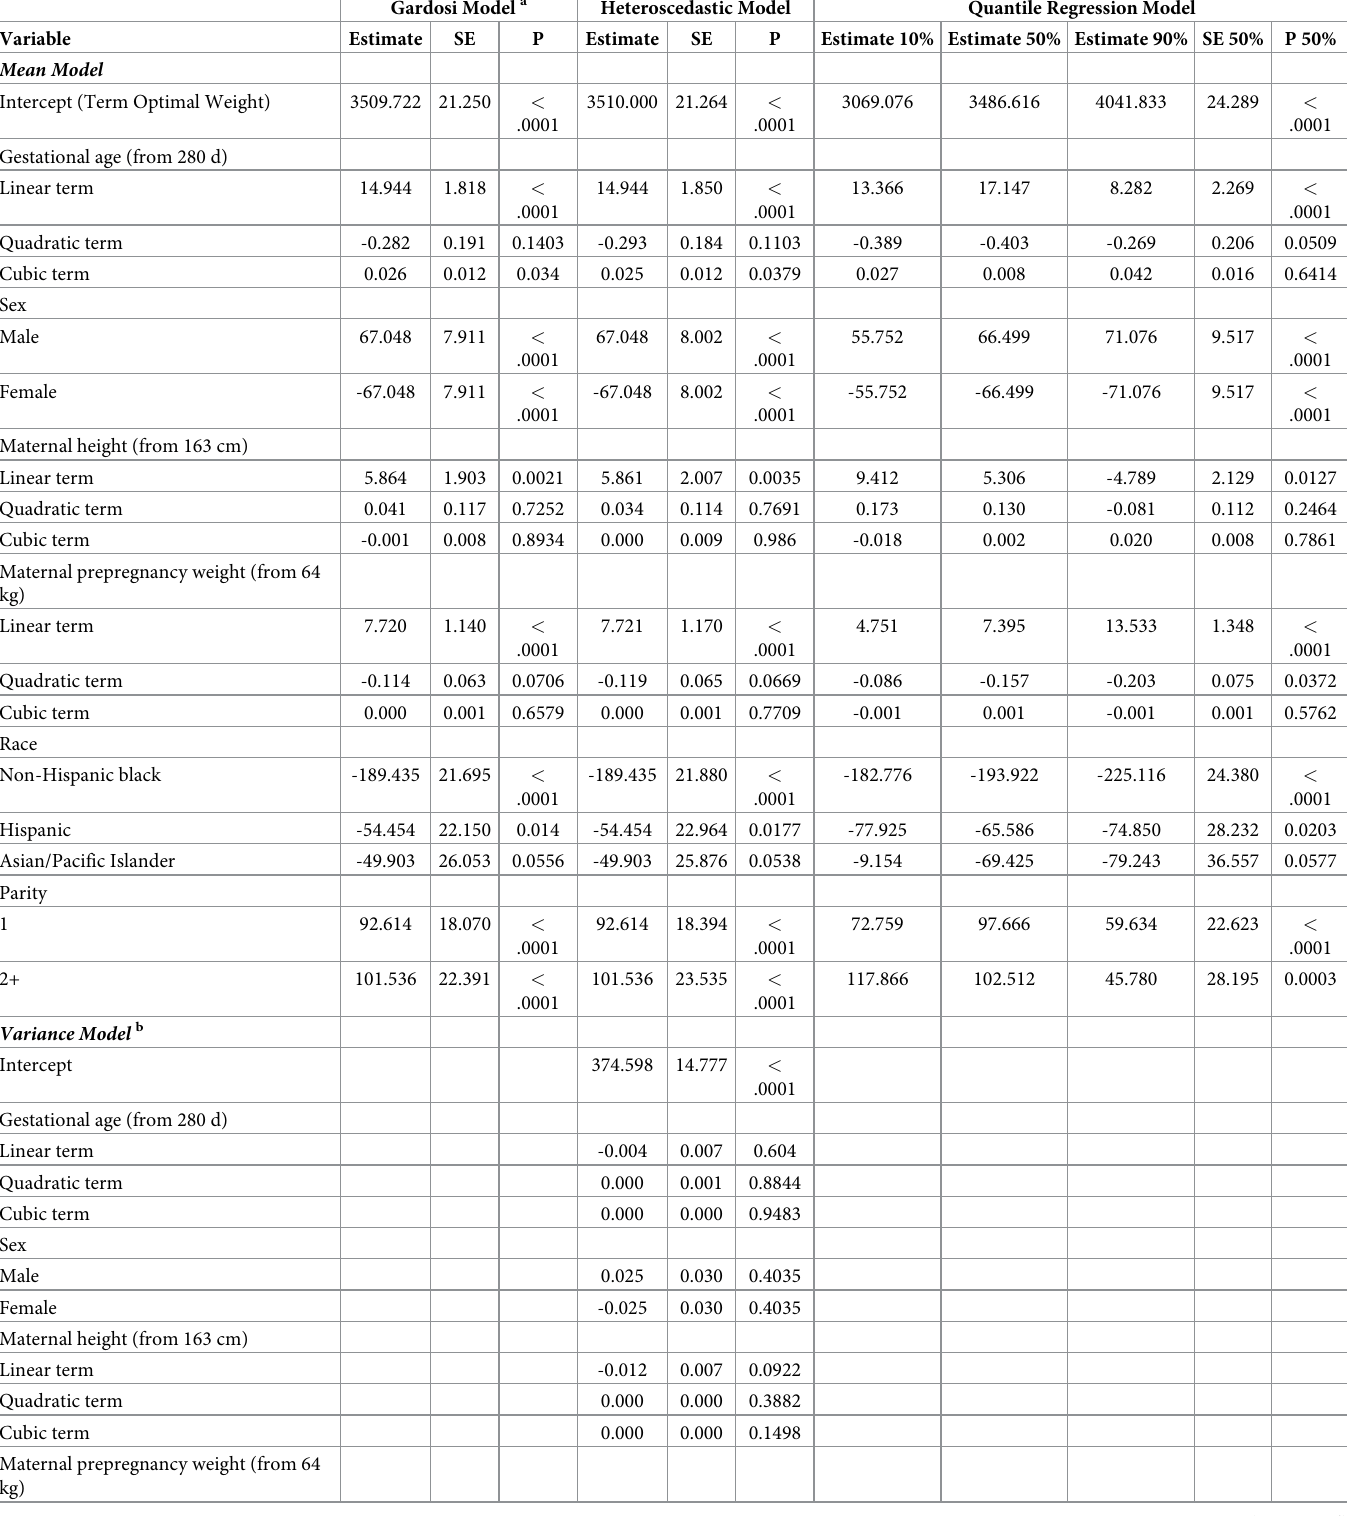
Table 2. Coefficients for three customization models in the NICHD Fetal Growth Studies–Singletons (N =